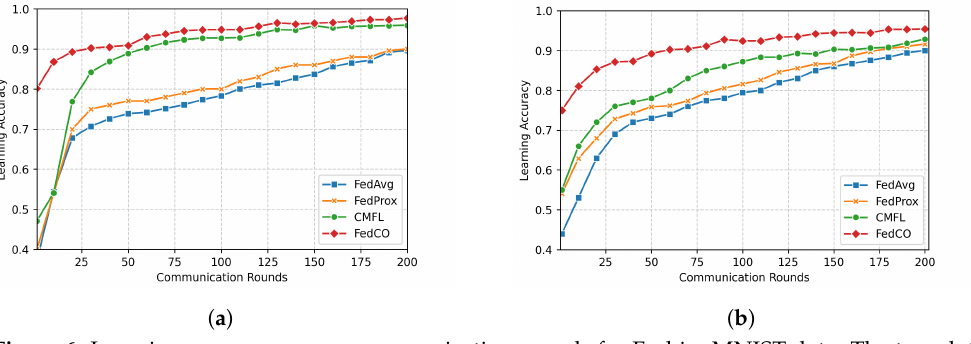
Figure 6. Learning accuracy versus communication rounds for FashionMNIST data. The top plot presents the results produced in the case of the IID data distribution scenario, while the bottom plot depicts the results generated in the case of the Non-IID data distribution scenario. ( a ) IID; ( b ) Non-IID.